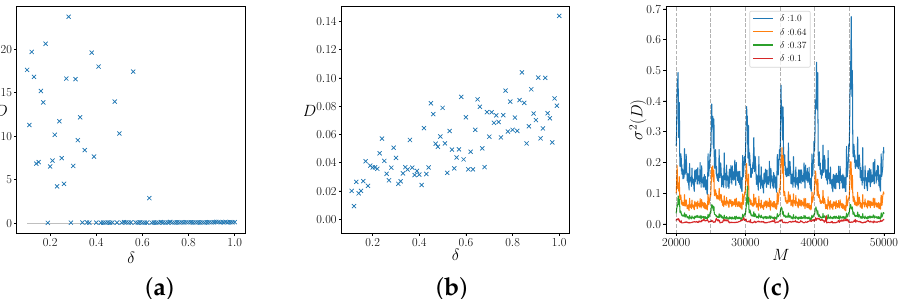
Figure 7. Parameter distance D after M repetitions for different amplitudes δ with ( a ) Q ( i ) randomly initialized in the interval ( 0.5,30 ) and ( b ) Q ( i ) initialized near the “true” values Q by adding a random noise of amplitude (cid:101) = 0.5. ( c ) Variance of the distance D for different amplitudes δ for the last interval. The vertical lines indicate when the ensemble was restored to t = 0. The Q ( i ) are initialized as in ( a